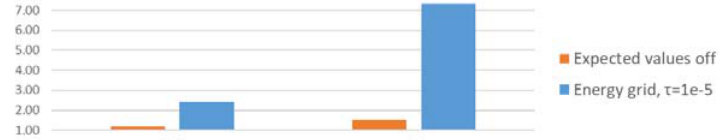
Figure 4. Dependence of speedup on run-time Doppler broadening on Minicore Criticality Testcase